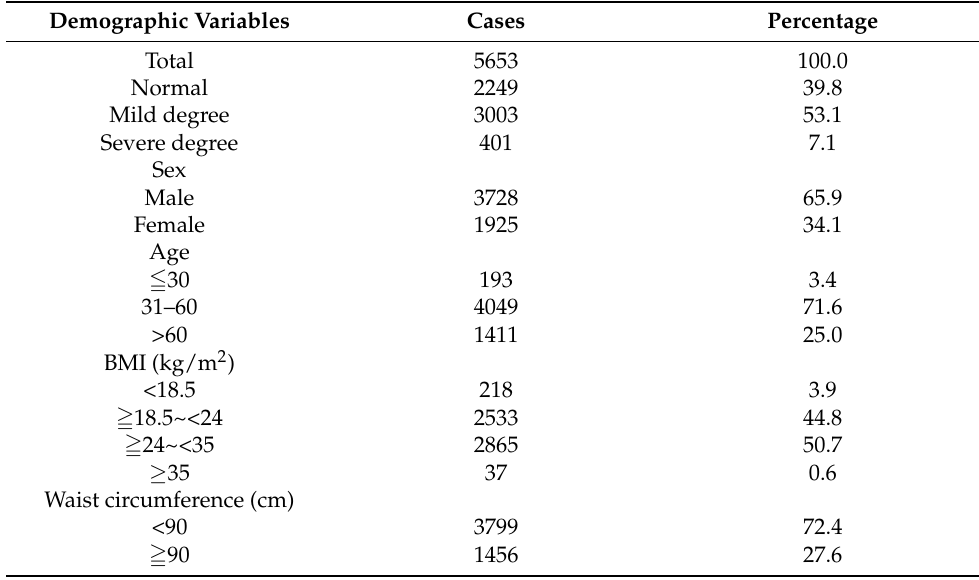
Table 1. Statistics of demographic variables ( n =